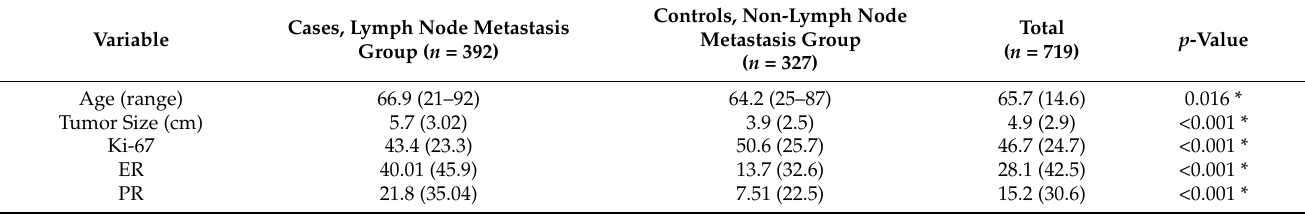
Table 2. Patient characteristics (NST criteria